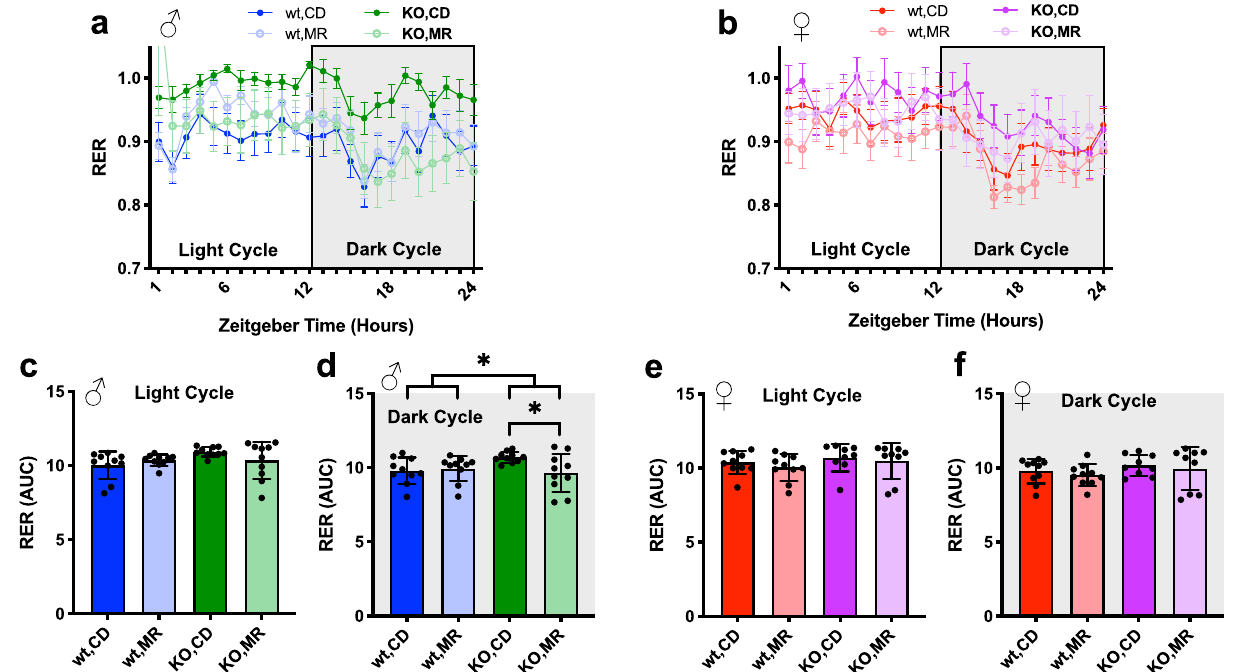
Figure 5. MR had minimal impact on RER. Respiratory Exchange Ratio (RER) for 24 h period ( a ), ( b ), analyzed via 3-Way ANOVA for light and dark cycle independently. Graphs represent mean ± s.e.m. Male light cycle ( c ) and dark cycle ( d ) AUC, and Female light cycle ( e ) and dark cycle ( f ) analyzed within each sex via Two-Way ANOVA for main effects on Area Under the Curve (AUC) for RER. Post-hoc analysis was performed with Sidac multiple comparisons correction to assess the diet effect within each genotype. Line graphs represent means ± s.e.m., bar graphs represent means ± s.d., and all groups were 9–10 mice on diet for ~ 8 months. (* p <